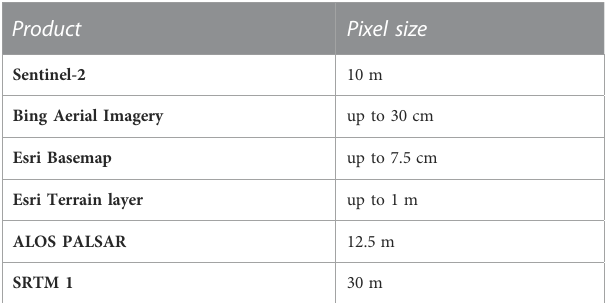
TABLE 1 Spatial resolution attributes for the remote sensing data used in this